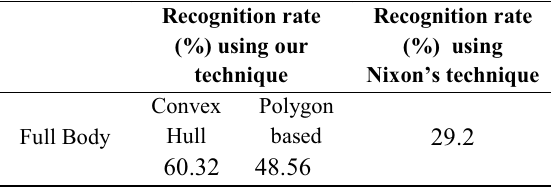
Table 18. Experimental comparison with Nixon et.al [29